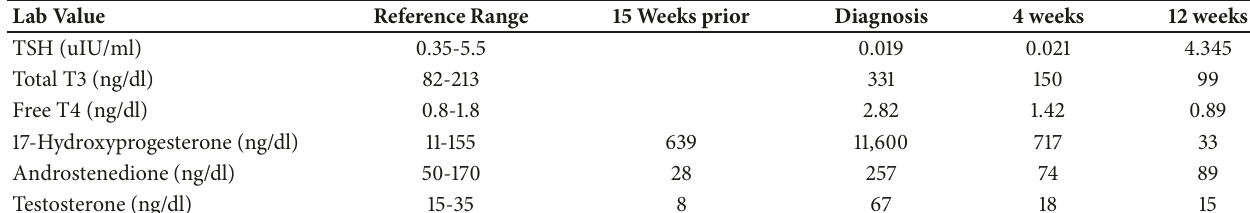
Table 1: Androgens and thyroid studies at baseline, diagnosis, and after 4 and 12 weeks of treatment. Lab Value